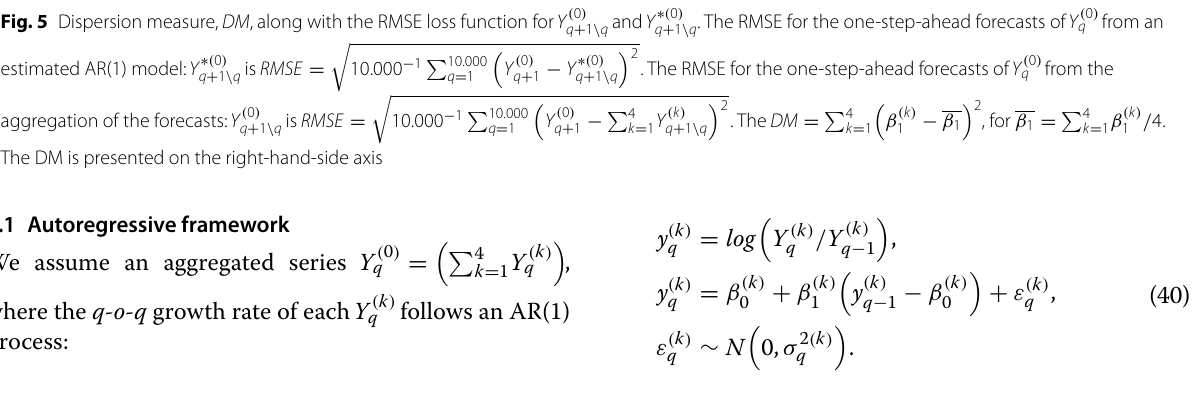
0 ) ∗ ( 0 ) q + 1 \ q and Y q + 1 \ q . The RMSE for the one-step-ahead forecasts of Y 2 . The RMSE for the one-step-ahead forecasts of Y (